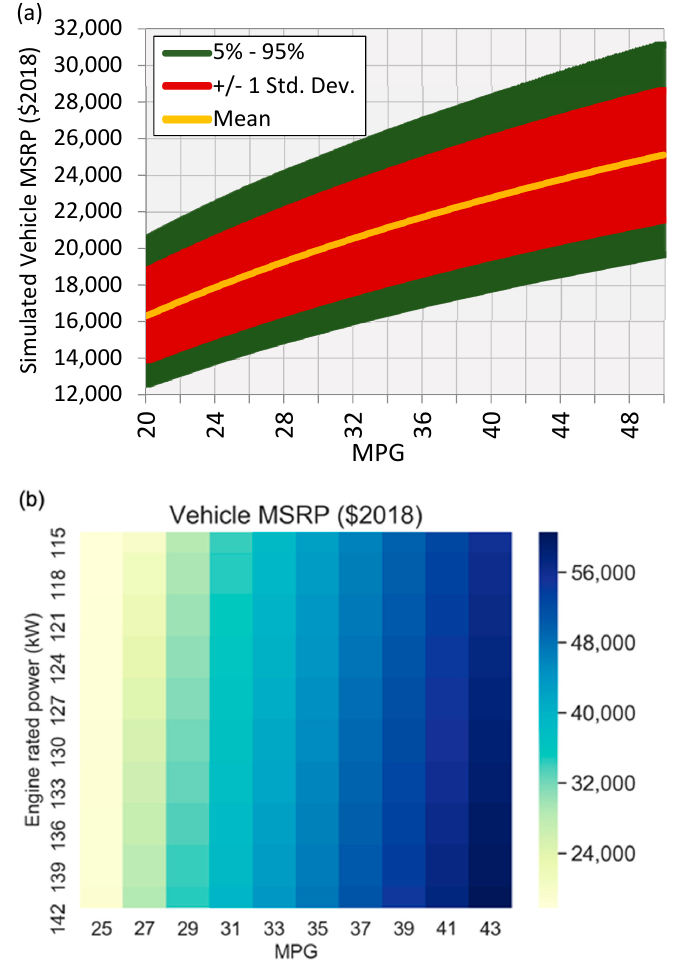
Figure 14. ( a ) The relationship between MSRP and fuel economy for a Chinese brand midsize vehicle; and ( b ) the effect of fuel economy and engine rated power on MSRP for a Chinese brand midsize vehicle.